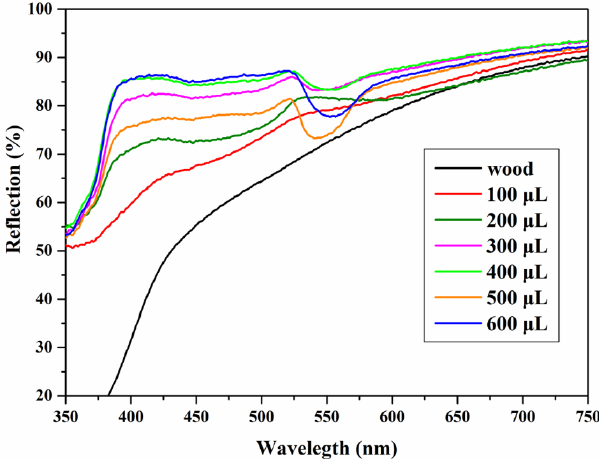
Figure 16. Reflection spectra of photonic crystals formed by different amounts of the P(St-AA) emulsion on a 35 mm × 35 mm wood surface.